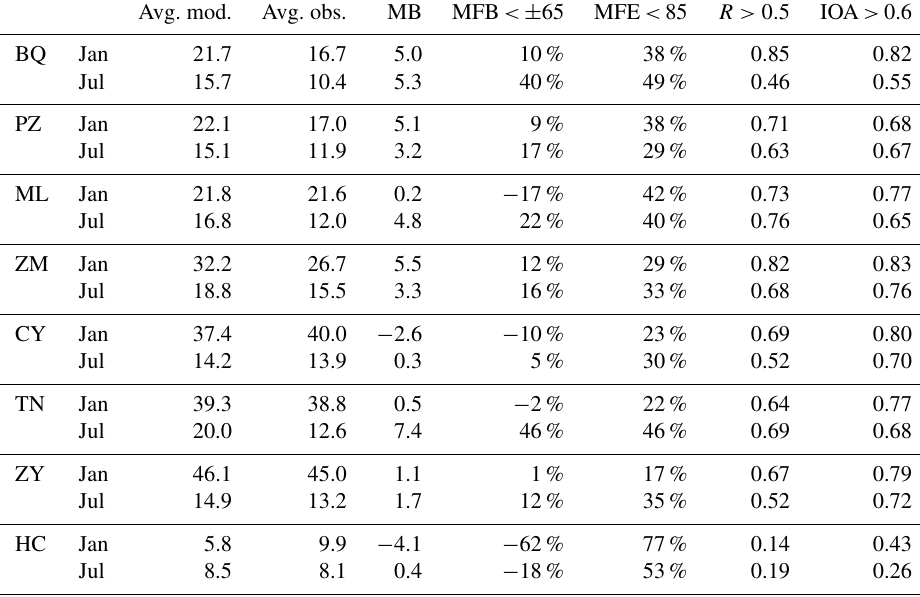
Table 2. Simulated PM 2 . 5 at eight air quality stations in western Taiwan. Avg. mod. Avg. obs. MB MFB < ±